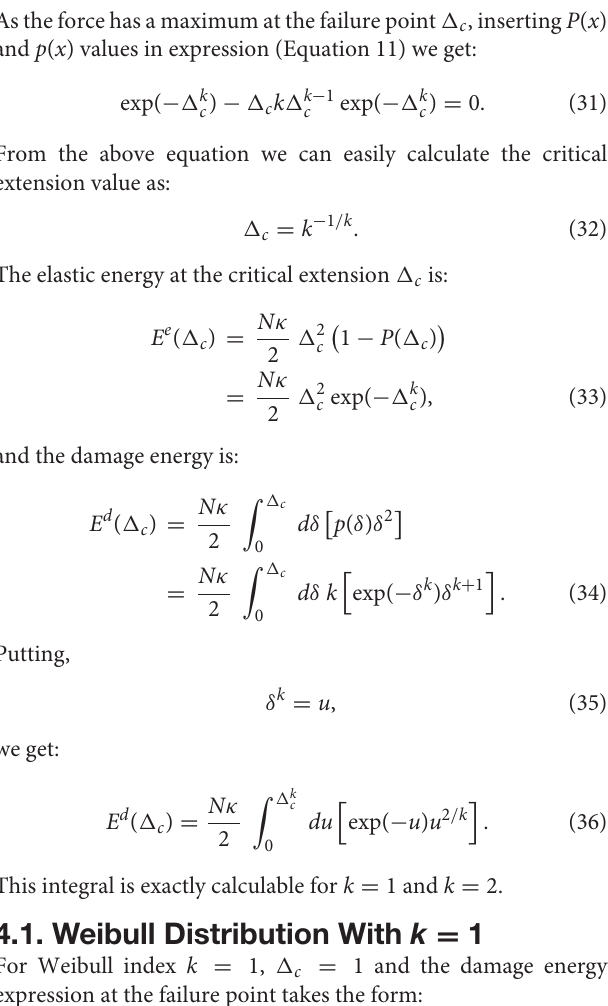
FIGURE 6 | Ratio between damage energy and elastic energy vs. extension 1 (up to the failure point 1 c ) for a fiber bundle with Weibull distribution of thresholds. In simulation, we used a single bundle with N and triangle are the theoretical estimates (Equations 40, 44) for the ratios at the failure point 1 c